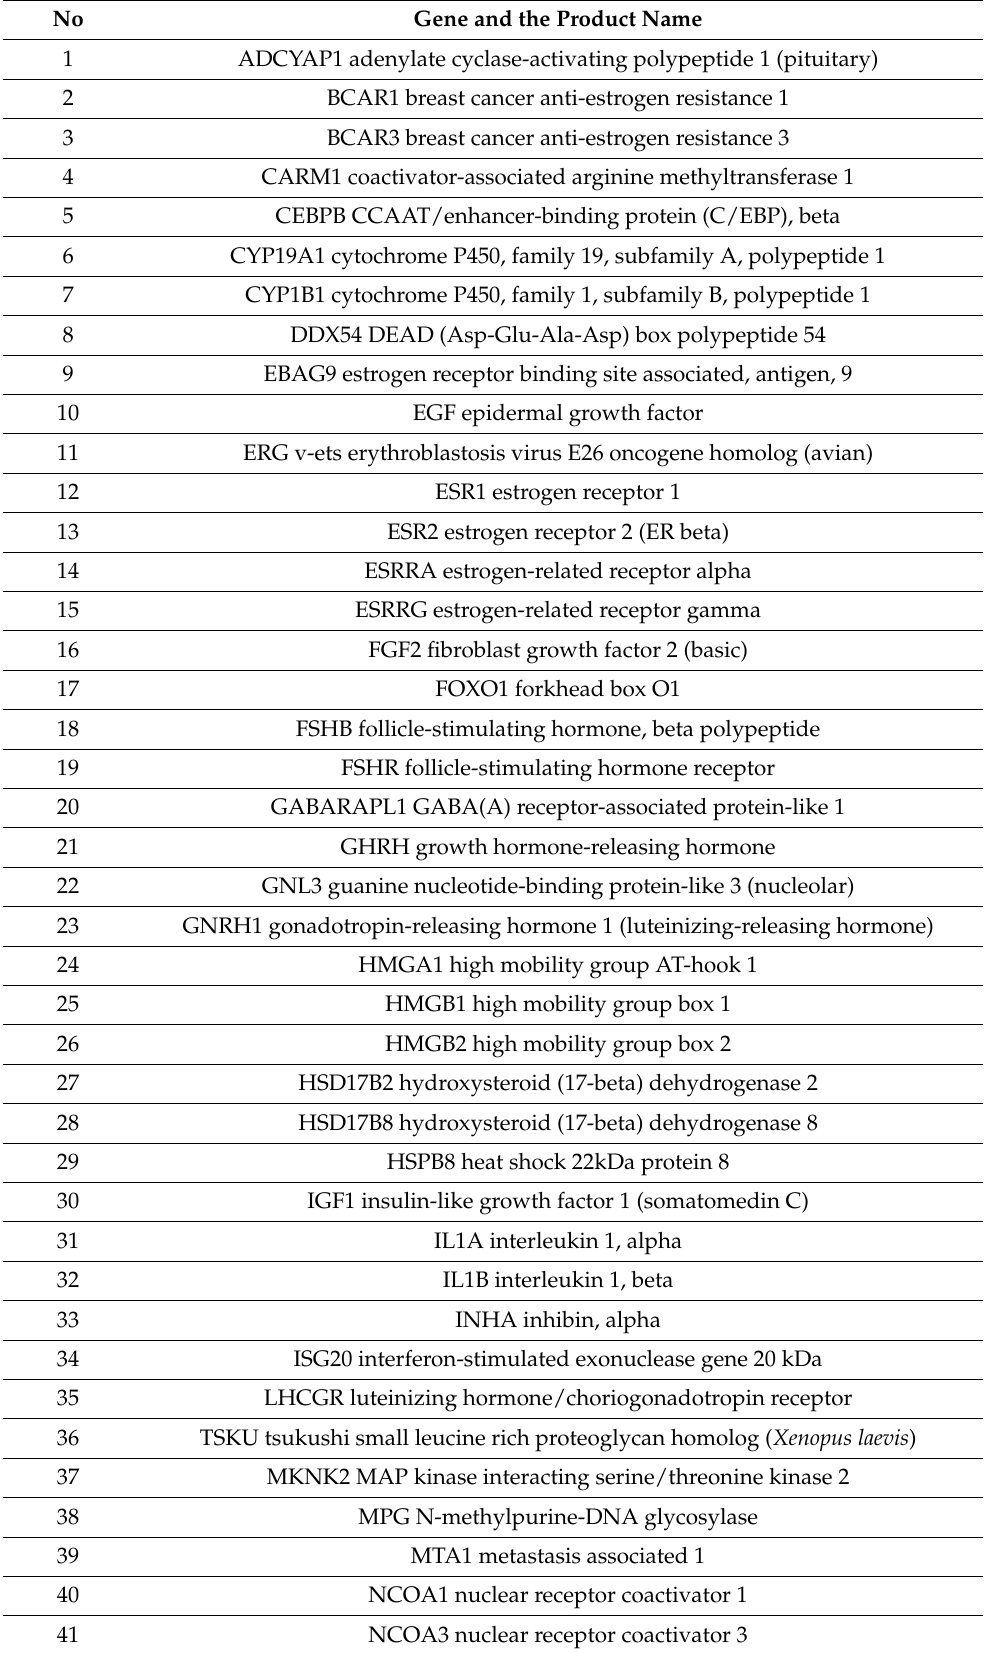
Table 2. Biomol GmbH Human Estrogen Signaling Primer Library, Cat. No: HESR-1—a set of commer- cial primers used to analyze the expression of the examined genes in MCF-7 breast cancer